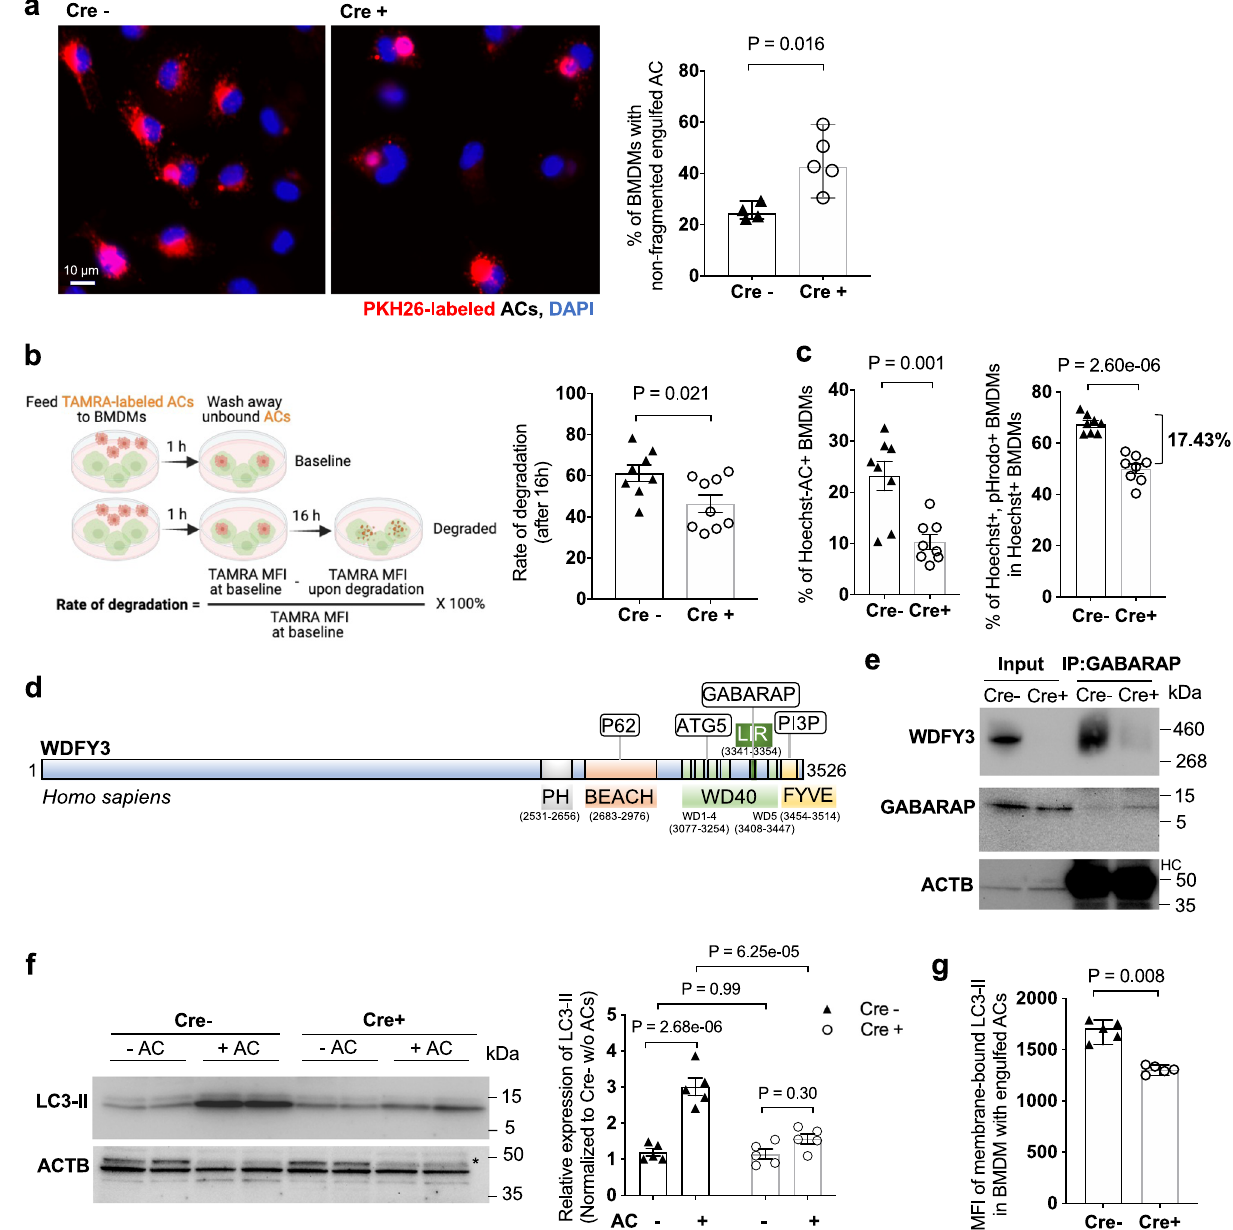
Fig. 3 | WDFY3 de fi ciency led to defects in LC3-associated phagocytosis (LAP) and the degradation of engulfed ACs. a Cre − and Cre + BMDMs were incubated with PKH26-labeled ACs for 1h. After washing away the unengulfed ACs, BMDMs were placed back to the incubator for another 3h. BMDMs were then fi xed and imaged. The percentage of BMDMs showing non-fragmented PKH26 signals in the totalnumberofPKH26 + BMDMswasquanti fi ed( n =4and5biologicalreplicatesfor Cre − andCre+respectively,eachfromtheaverageof3technicalreplicates). b Cre − and Cre + BMDMs were incubated with TAMRA-labeled ACs for 1h. After washing away the unengulfed ACs, BMDMs were either collected for fl ow cytometry to quantify the MFI of TAMRA or placed back to the incubator for another 16h and thencollectedfor fl owcytometry.Therateofdegradationwascalculated,asshown in the schematics ( n =8and 9biologicalreplicatesforCre − and Cre+ respectively). c Cre − and Cre + BMDMs were incubated with ACs labeled by Hoechst, which stains DNA and is pH-insensitive, and pHrodo, which is pH-sensitive and shows fl uor- escent signal only under an acidi fi ed environment in the phagolysosome. The percentage of Hoechst + BMDMs indicates uptake. The percentage of Hoechst + /pHrodo + BMDMs in Hoechst + BMDMs indicates acidi fi cation of the engulfed cargos ( n =8 biological replicates, each from the average of 2 technical